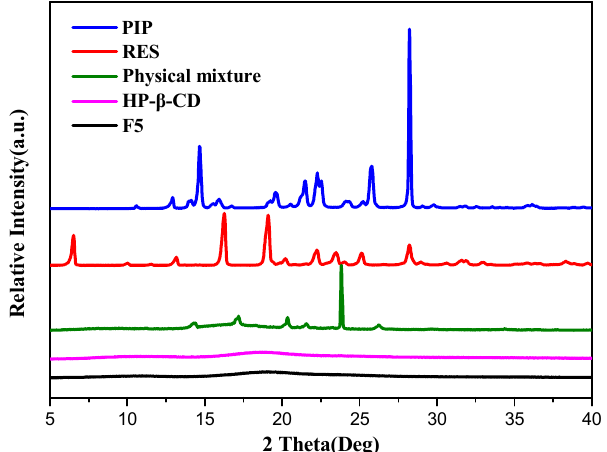
Figure 5. XRD profiles of RES, PIP, HP- β -CD, physical mixture, and representative spray-dried microcapsules (F5).